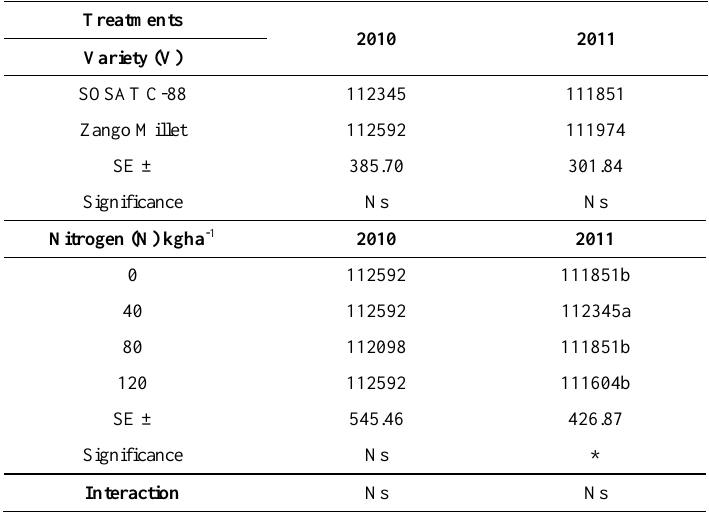
Table 1. Effect of varieties, nitrogen levels on Stand count during 2010 and 2011 cropping seasons at Usmanu Danfodiyo University Teaching and Research Dry Land Farm, Sokoto